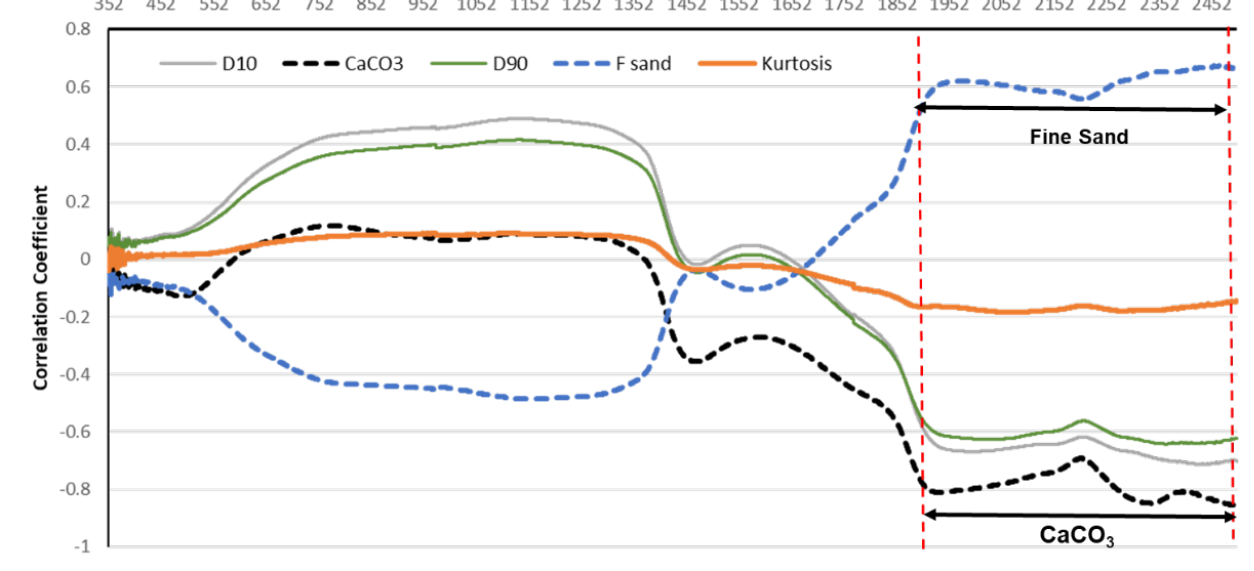
Figure 6. Correlation coefficient between reflectance values at different spectral wavelengths and sediment CaCO 3 , and particle size characteristics. Table 4. Analysis of p -values of linear regression of CaCO 3 , fine sand and grain size span with selected wavelengths (see Figure 5). Significance levels are: ˆ 0.1, * 0.05, ** 0.01 and ***